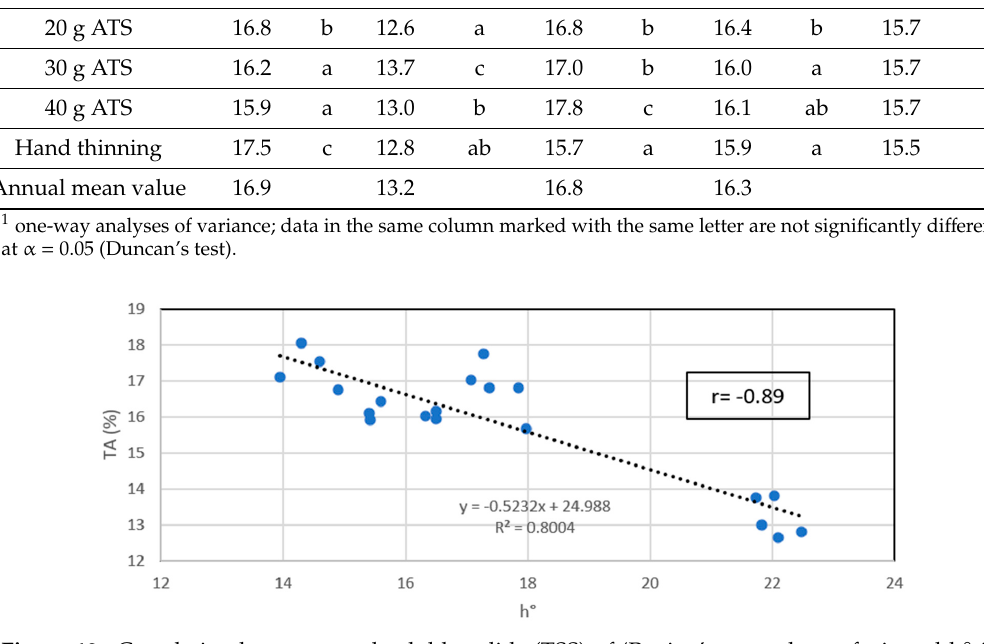
Table 5. The effect of thinning on the hue value (h°) of ‘Regina’ sweet cherry fruit—mean values for